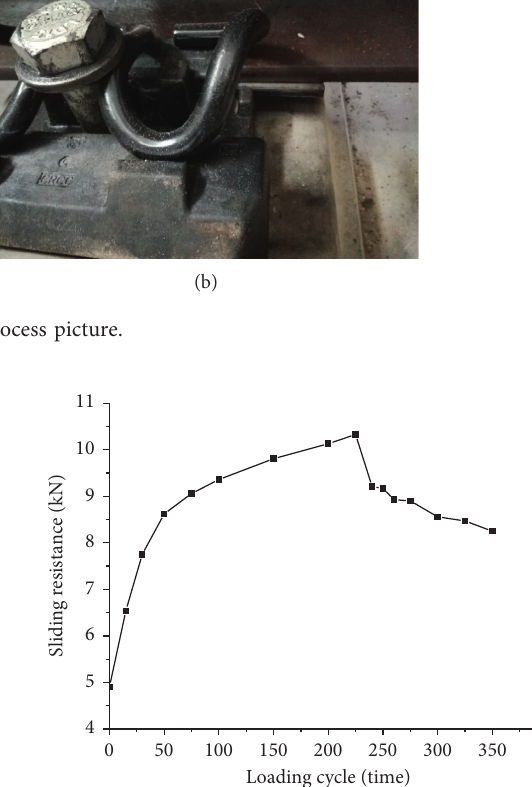
Figure 7: Relationship between sliding resistance and the loading cycle.